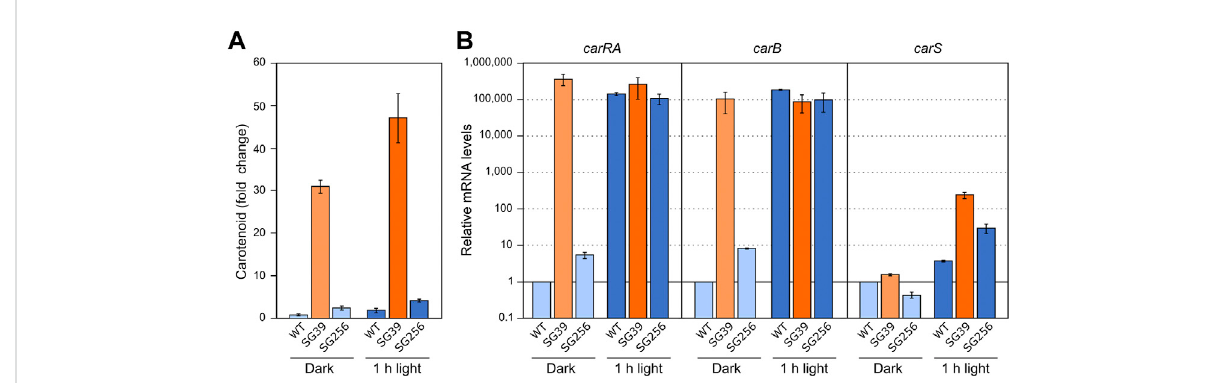
FIGURE 2 Effect of light and carS gene mutation on carotenoid production and expression of car genes. (A) Relative carotenoid content in the wild type (WT), carS mutant(SG39),andthecomplementedmutant(SG256).AbsolutecarotenoidcontentsareshowninSupplementaryTableS1.Carotenoids were analyzed in mycelia incubated for 24 h after the 1-h illumination in the Petri dishes or without illumination. (B) Transcript levels of carRA, carB, and carS genes. The three strains were cultivated for 3 days in shake fl asks with DG medium at 30 ° C in darkness, 25 ml of the cultures were transferred to Petri dishes and were illuminated with white light for 1 hour or incubated in darkness. Levels of mRNA were determined by RT-qPCR and referred to the levels in the wild type grown in the dark, taken as 1.